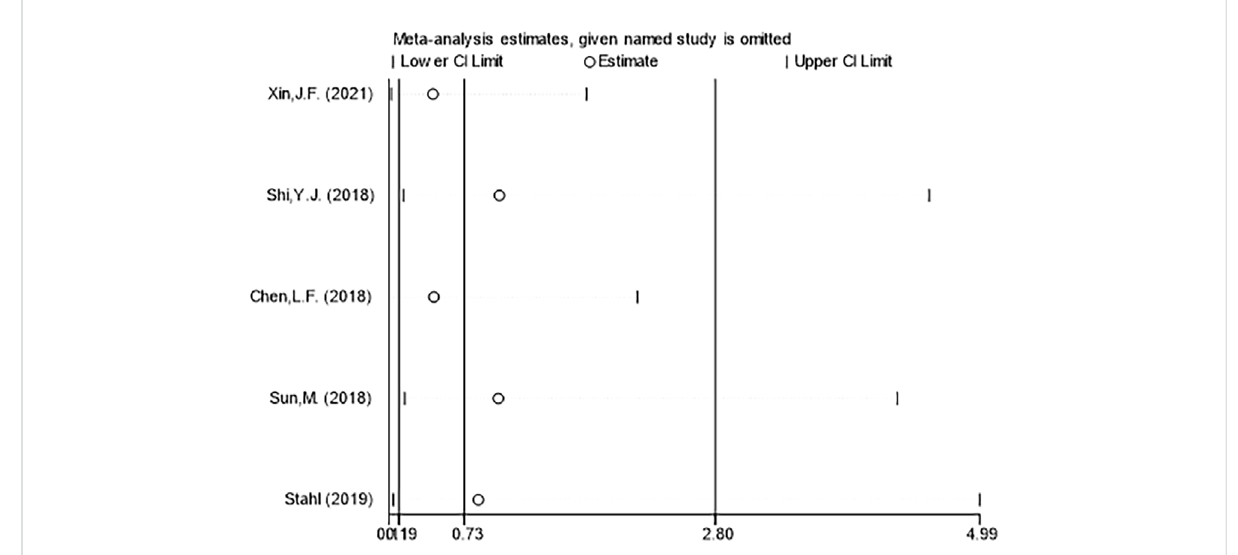
FIGURE 8 Sensitivity analysis of the incidence of adverse events between ranibizumab and laser therapy for retinopathy of prematurity (ROP).